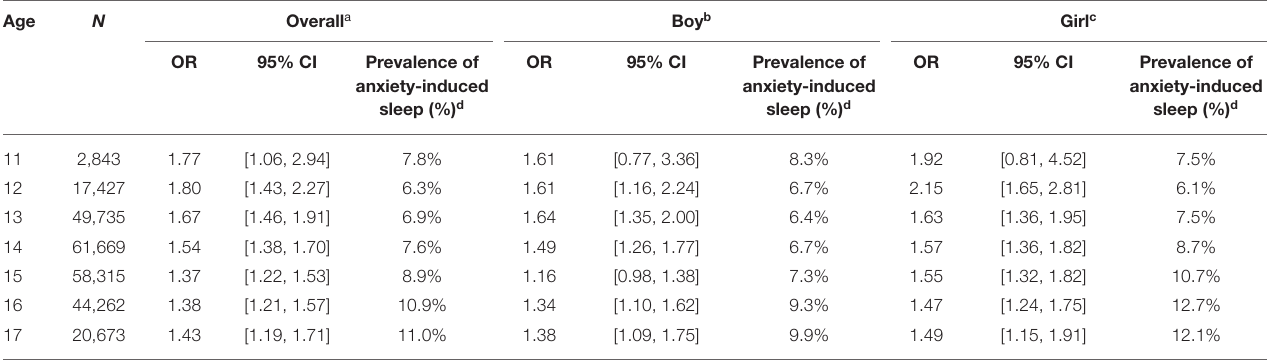
TABLE 3 | The relationship between sedentary time ( ≥ 3 h/day) and anxiety-induced sleep disturbance estimated multivariable logistic regression based on age (overall and by gender). Age